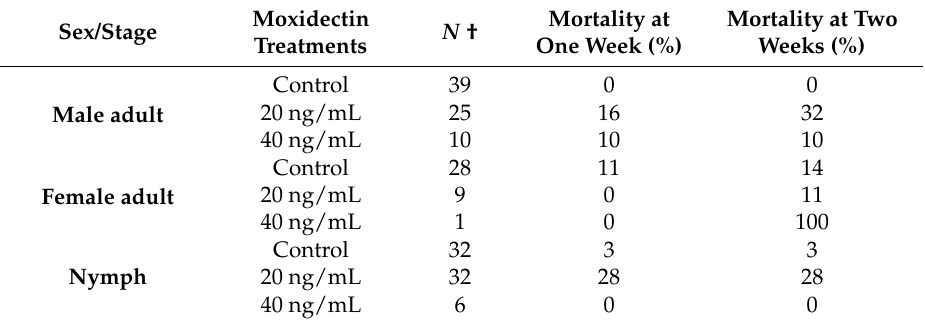
Table 4. Mortalities of bed bugs after the second moxidectin feeding.